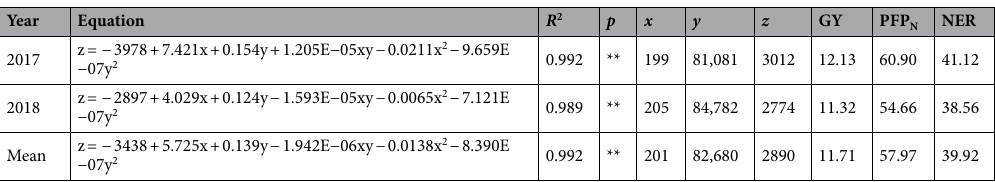
Table 3. The quadratic polynomial trend surface equations, and yield, PFP N and NER. R 2 the coefficient of determination, x represents the N application rate (kg ha −1 ), y represents the planting density (plant ha −1 ), z represents the profit, GY represents the grain yield (t ha −1 ), PFP N represents partial factor productivity of applied N (kg kg −1 ), NER represents nitrogen efficiency ratio (%). **Represents significance at the 0.01 probability